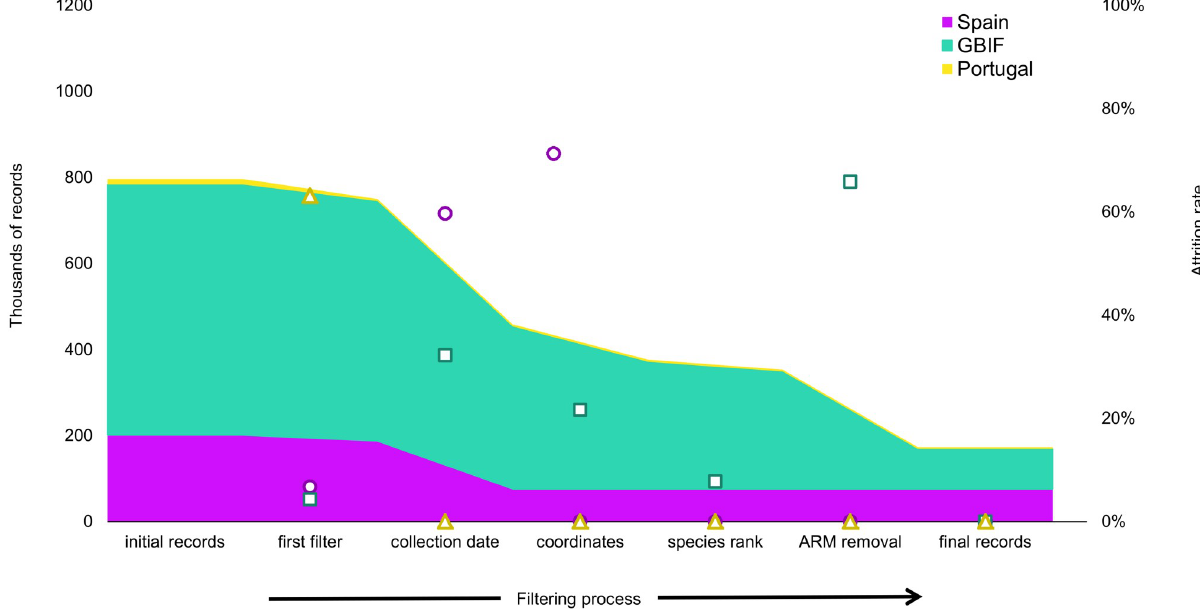
Fig 1. Number of records removed in each step of the filtering process for the three sources of data: Global Biodiversity Information Facility (GBIF), Spanish and Portuguese national atlases. Points show the leakage rate in each filtering step for each source of data. The first filter kept records from wild terrestrial mammals distributed in the Iberian Peninsula. The second filter removed records lacking collection date or species determination, and those having coordinates issues. ARM removal is the additional filtering step applied to the GBIF dataset to remove the data from the National Inventory of Terrestrial Species of Spain. The aggregation step collapsed the information by using the combination of scientific name, coordinates, and collection year.